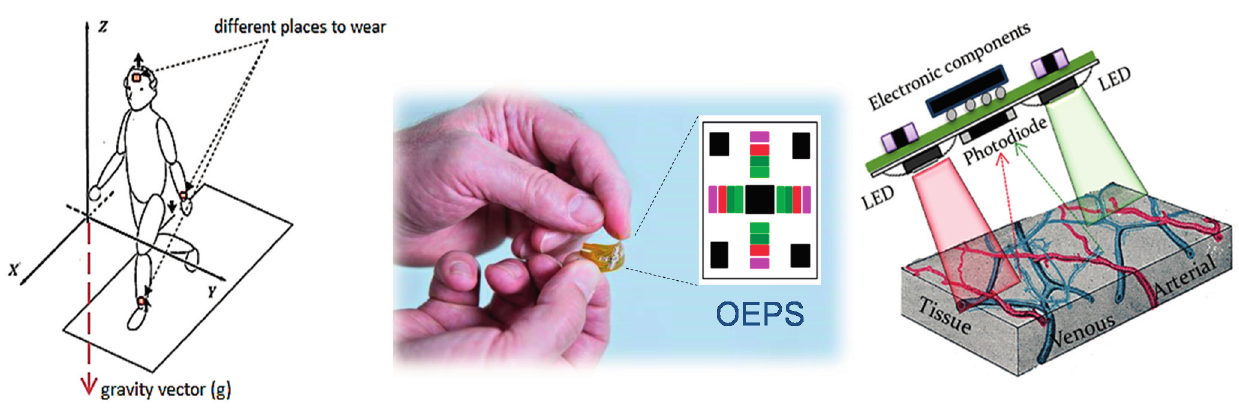
Figure 6. Flexible OEPS for continuous physiological monitoring and its viable